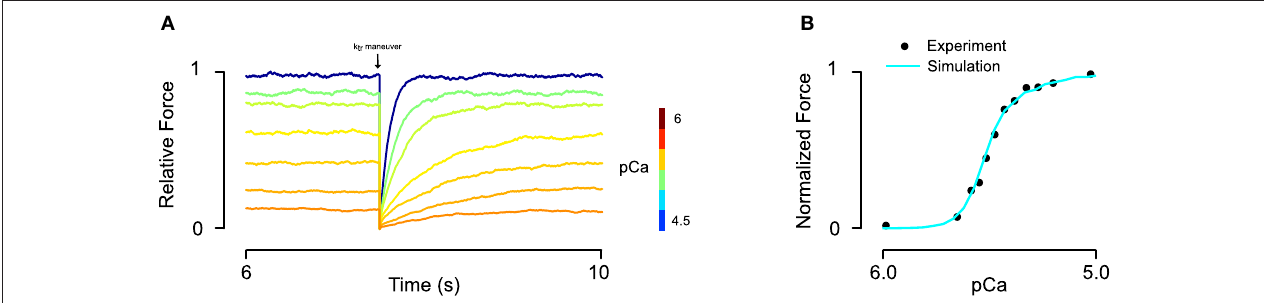
FIGURE 2 | Fitting of skinned rat trabeculae steady state force-pCa data. (A) The model showed realistic calcium dependence of steady-state force and the rate of force development ( k tr ) after a slack-restretch maneuver. (B) The model was able to fit steady-state force-pCa data and recapitulate the asymmetric Hill coefficient observed in experiments (data from Dobesh et al., 2002).